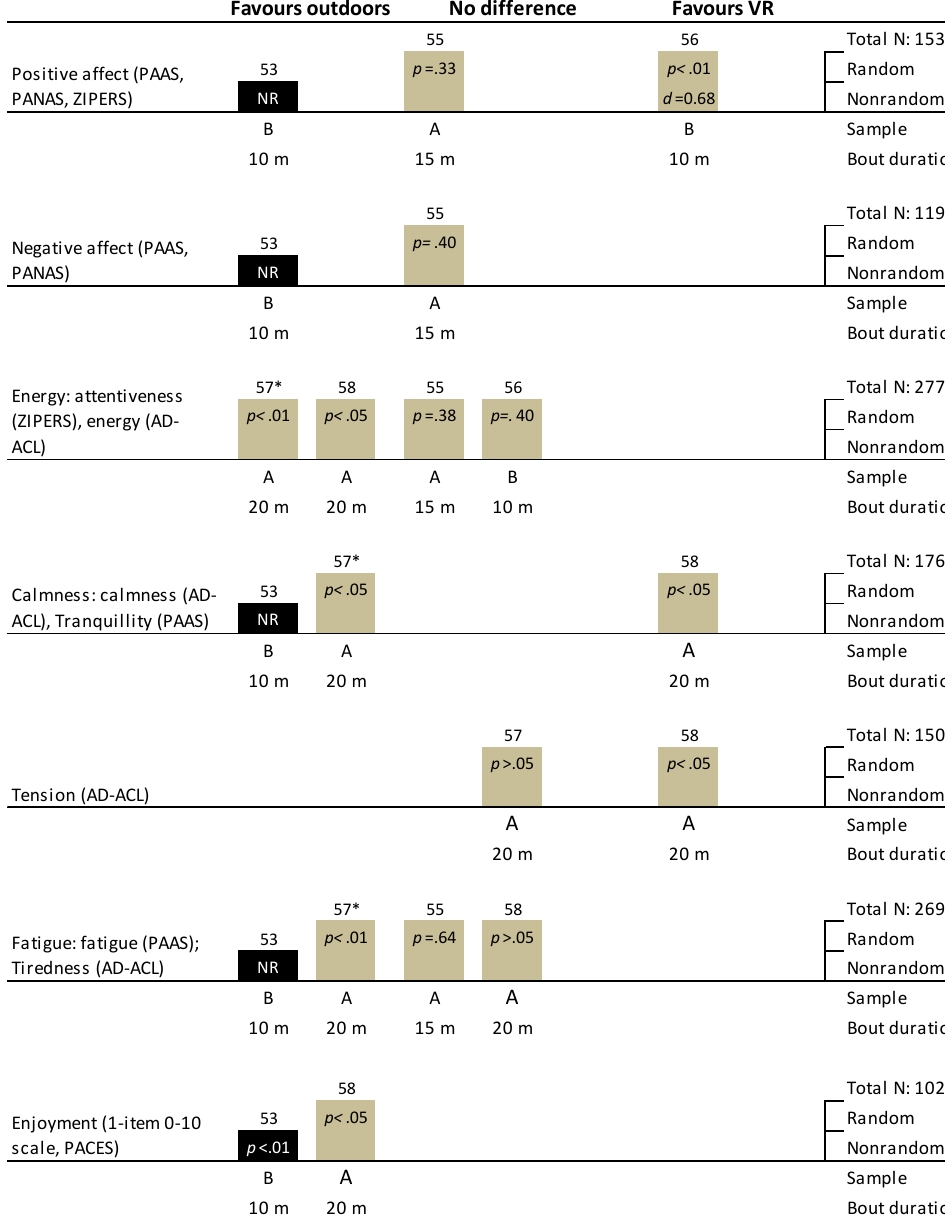
Figure 6. Harvest plots of trials investigating outdoor green exercise versus virtual green exercise. Note: A: studies with ≥ 40 participants; B: studies with 20–39 patients; C: studies with < 19 patients. We also provide the total sample across trials for each comparison (note: Plante et al. 2003 and 2006 [57,58] did not provide group sample sizes, so we divided the total sample by the number of conditions to approximate group sizes). The taller bars represent randomized trials in this comparison, and shorter bars represent non-randomized trials. Tan bars indicate parallel group design trials, whereas black bars represent crossover design trials. p-values and effect sizes (i.e., Cohen’s d) are provided inside each bar where this information is available. The number on top of each bar represents the study’s reference number in the present systematic review. Exercise bout duration is provided in minutes. The number on top of each bar represents the study: 53 = Calogiuri 2018 [53]; 55 = Fuegen & Breitenbecher [55]; 56 = Gatersleben & Andrews [56]; 57 = Plante 2003 [57]; 58 = Plante 2006 [58]. Acronyms: VR: virtual reality; AD-ACL: Activation–Deactivation Adjective Check List; PACES: Physical Activity Enjoyment Scale; PAAS: Physical Activity A ff ect Scale; PANAS: Positive and Negative A ff ect Schedule; ZIPERS: Zuckerman Inventory of Personal Reactions. * Female participants